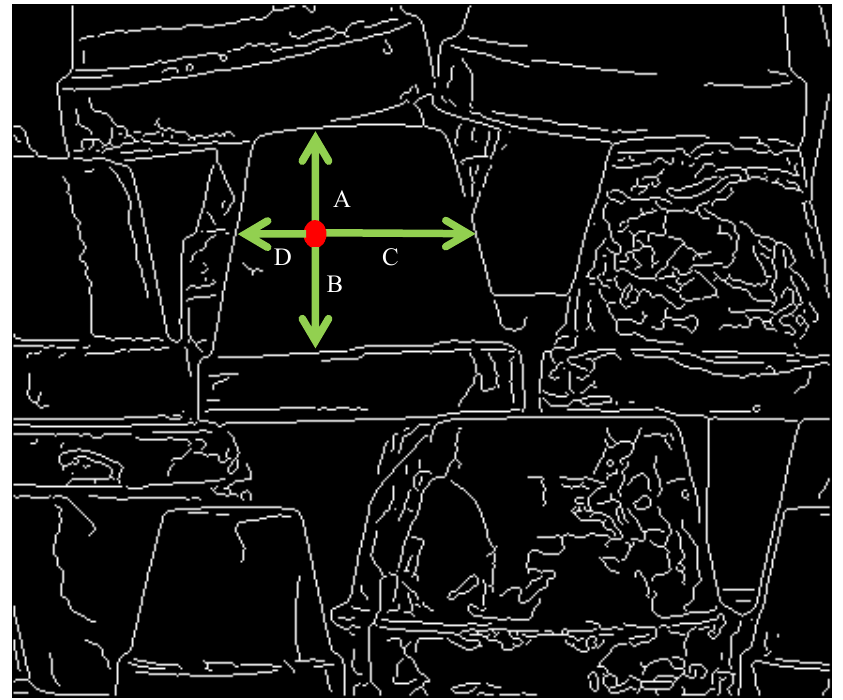
Figure 3. Example of the path searching of a (red) point.